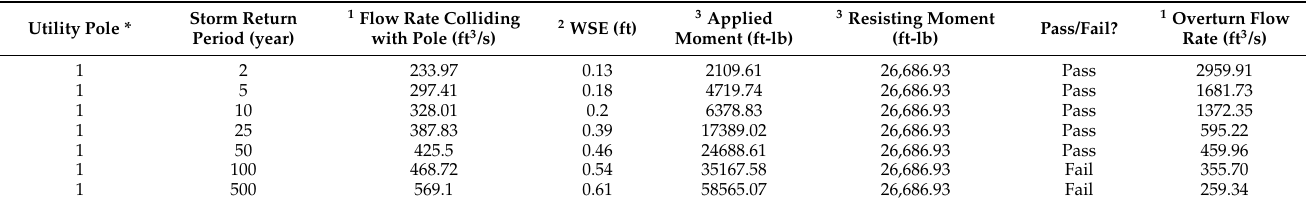
Table 3. Calculations template of parameters used to determine overturn flow rates as the model constraints for a flood-susceptible utility pole in Whittier, NC watershed.